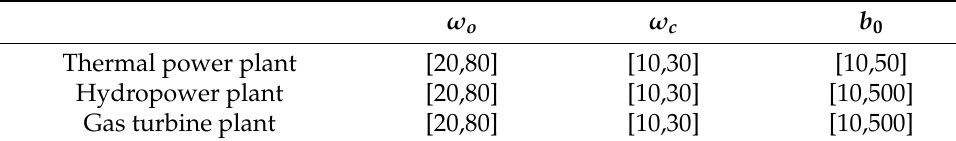
Table 3. Upper and lower bounds of controller